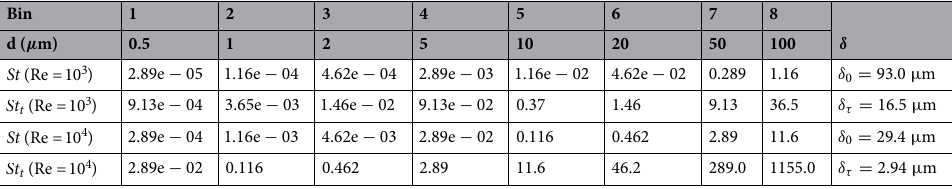
Table 3. Droplet sizes and Stokes numbers used in the